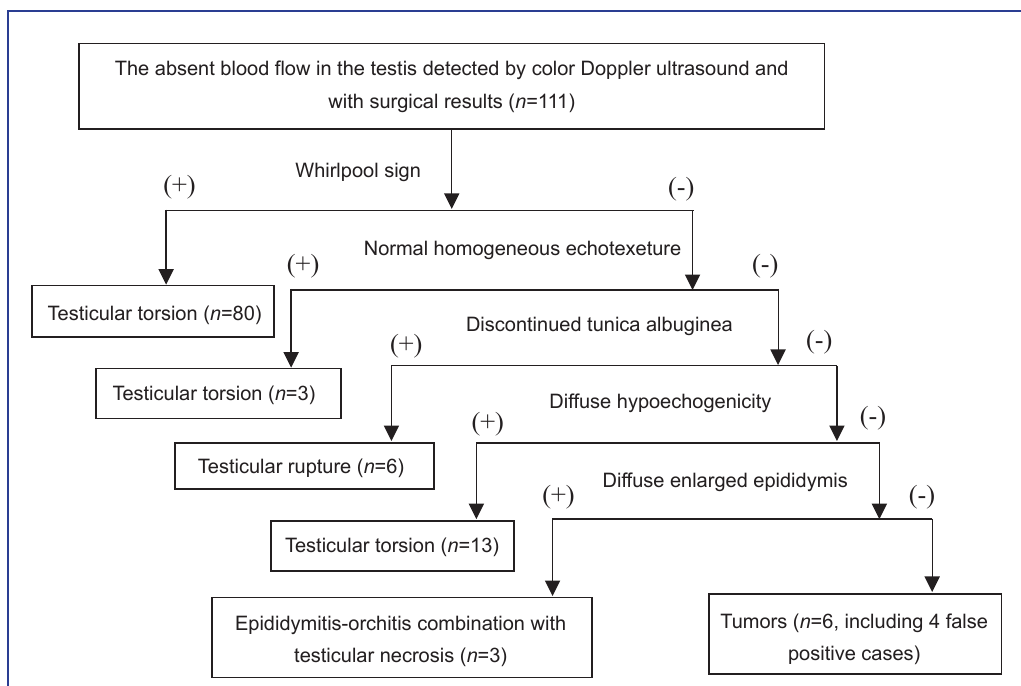
Figure 6 The ultrasonographic differential diagnostic route for the causes of absent blood flow in the testis detected by color Doppler ultrasound and with surgical